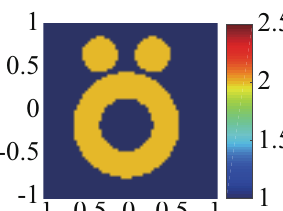
Figure 2. The exact profile of “Austria” profile (with ε r = 2.0). The colorbar shows the value of relative permittivity.